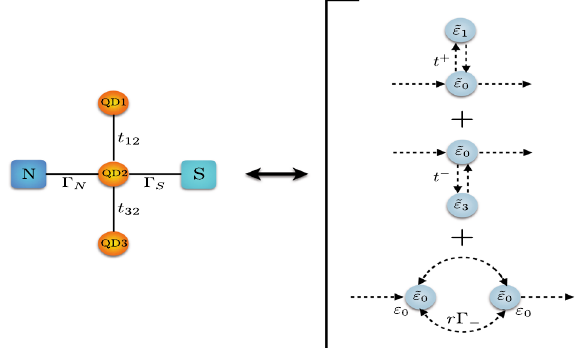
Figure 9. Scheme of the Andreev processes: equivalent path for the Fano-Andreev and Dicke-Andreev transmission. The complete process can be divided in two Fano effects and a transmission through equivalent quantum-dots in